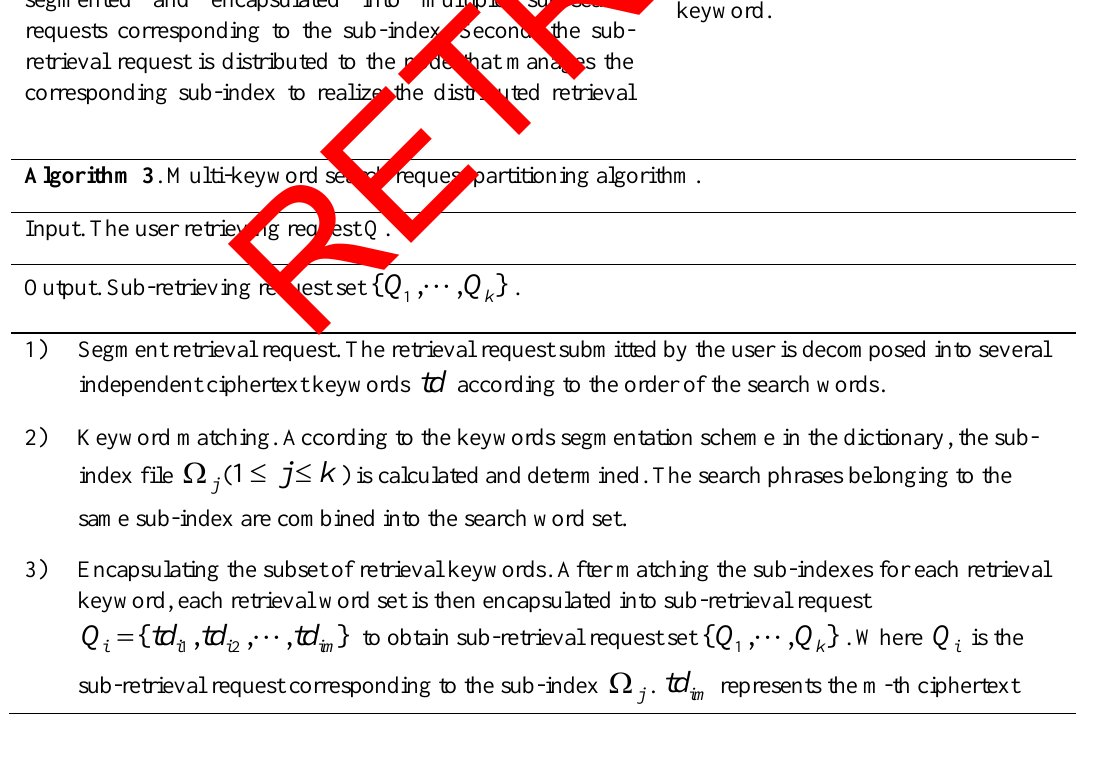
Algorithm 3 . Multi-keyword search request partitioning